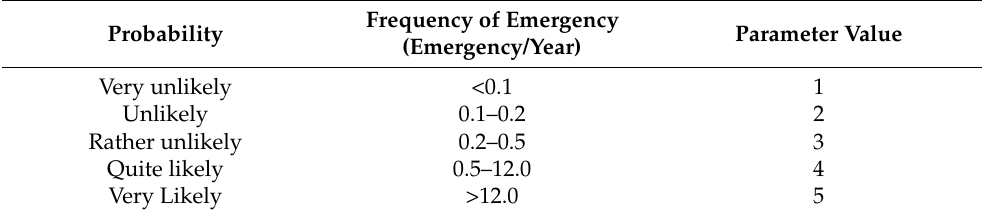
Table 1. The categorization of the parameter of probability (P) (own study based on [49], modified by [48]).